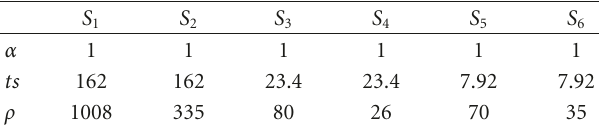
Table 4: Tra ffi c figures for unbalanced tra ffi c